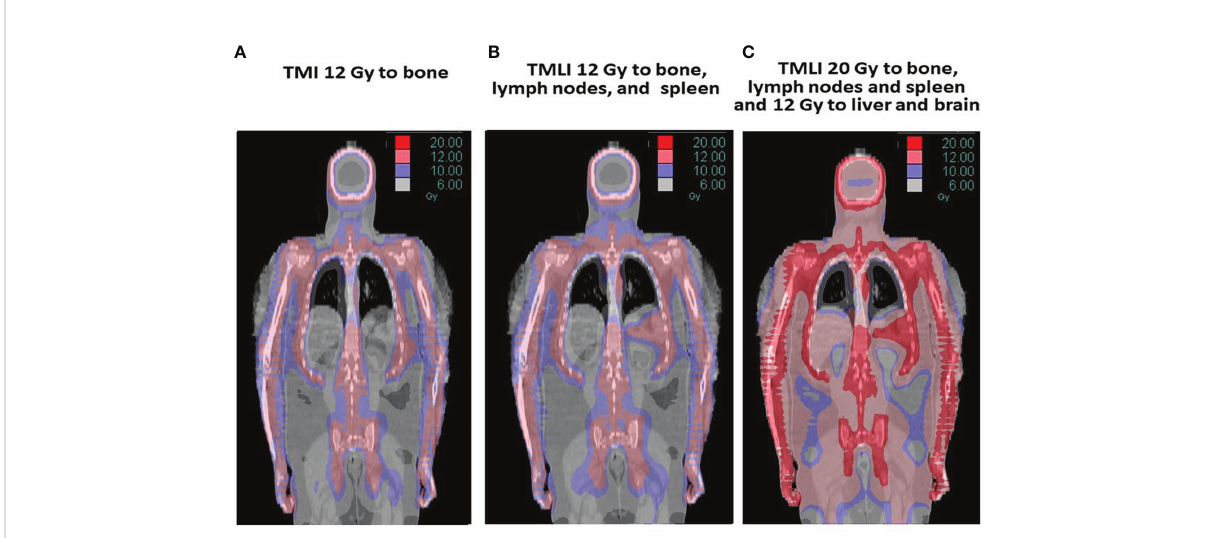
FIGURE 2 The term TMI is used if the target is bone (A) and was used in a tandem autologous HCT multiple myeloma trial (9, 10). TMLI adds the major lymph node chains and spleen as target regions and is used in allogeneic HCT regimens (B) (11). In some studies, TMLI also includes the liver and brain to 12 Gy while other target regions (bone, lymph nodes and spleen) are escalated to 20 Gy (C) (12,